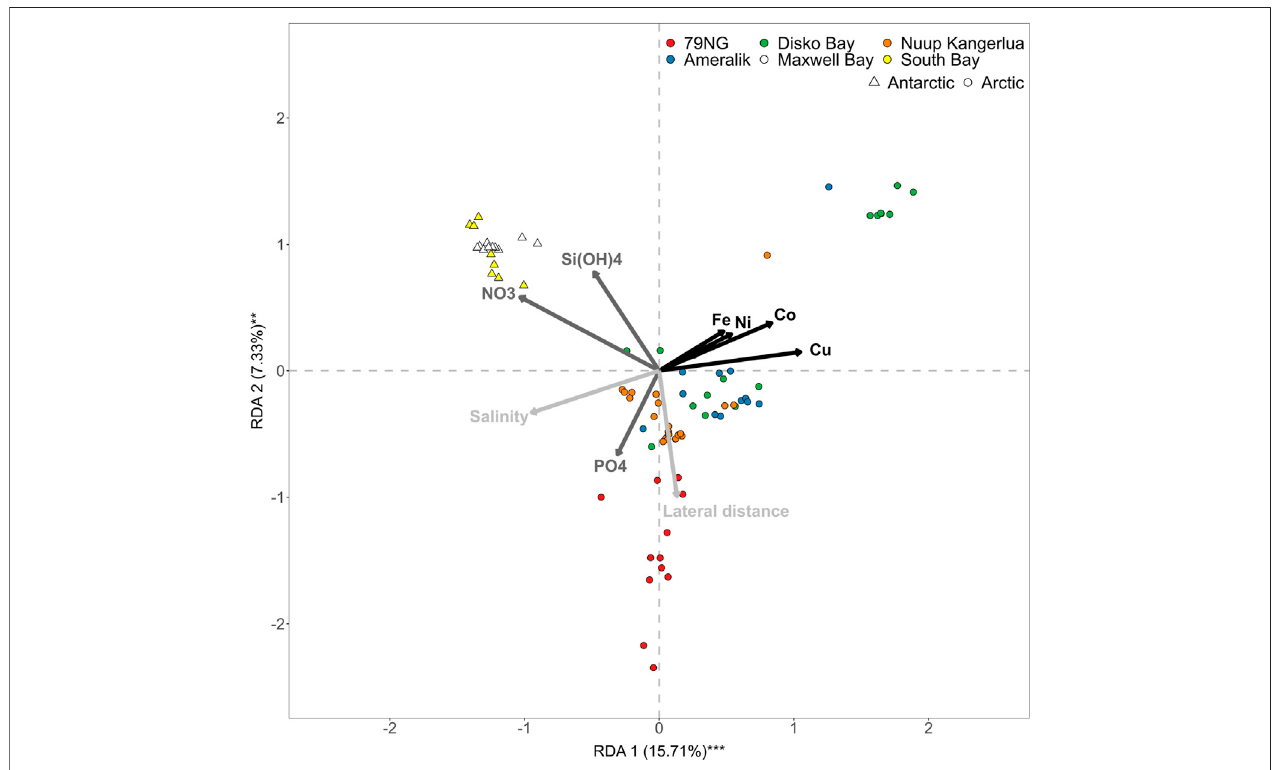
FIGURE 3 | Redundancy analysis for all trace metals and macronutrients across all sites in summer considering lateral distance and salinity as key explanatory variables.NotethedistinctclusteringofSouthernOcean sites(Maxwell BayandSouthBay) compared toallGreenlandic(Arctic) sites.Theangles betweenarrows show positive (0 ° ), negative (180 ° ) or no relationships (90 ° ) among the variables. Only summertime data are plotted.